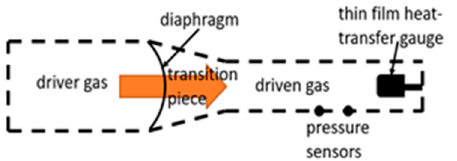
Figure 5. Schematic of a typical shock tube plasma system.